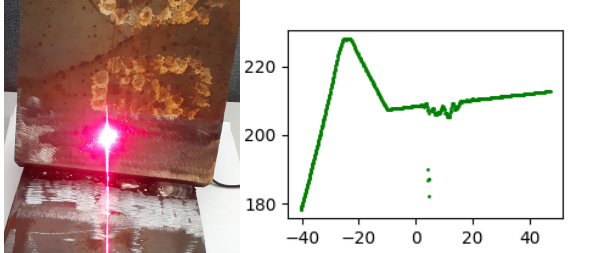
Figure 14. Reflections from laser projection onto shiny metal surface and the corresponding data noise in the